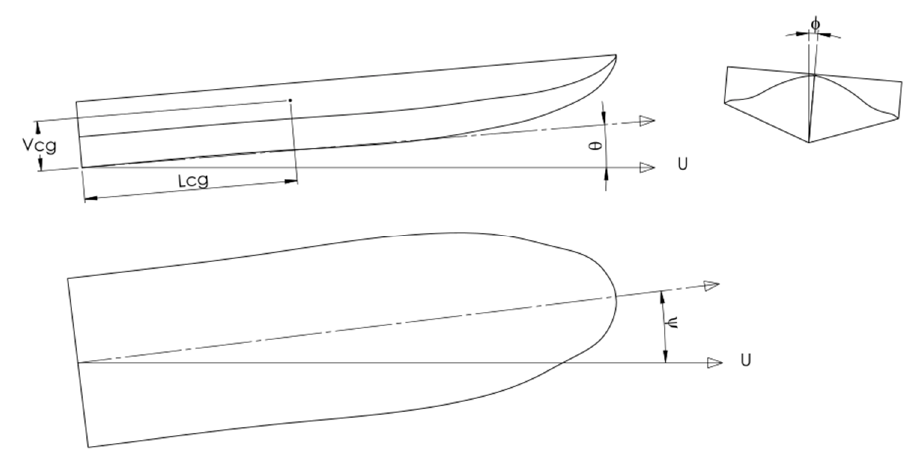
Figure 18. Steady condition boat.